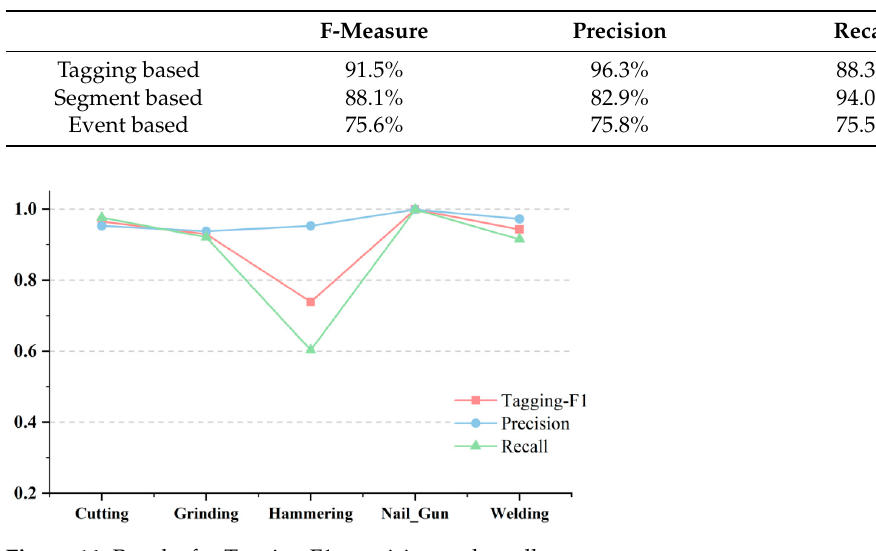
Figure 14. Results for Tagging F1, precision and recall.